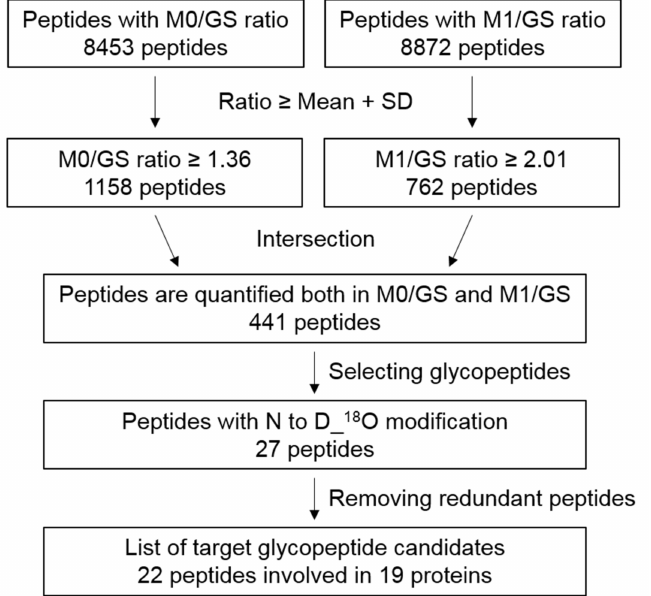
Figure 2. Flowchart for selecting candidate glycopeptides from glycoproteome analysis. From glycoproteome analysis, 8453 and 8872 peptides with quantified ratios in M0/GS and M1/GS groups were subjected to statistical analysis to determine mean and SD values. Peptides with ratios smaller than mean + SD were initially filtered out. The remaining 1158 and 762 peptides were intersected, leading to the identification of 441 peptides from which 27 harboring the modification of N to D_ 18 O were further selected. After removing redundant peptides, 22 peptides representing 19 proteins were selected as target